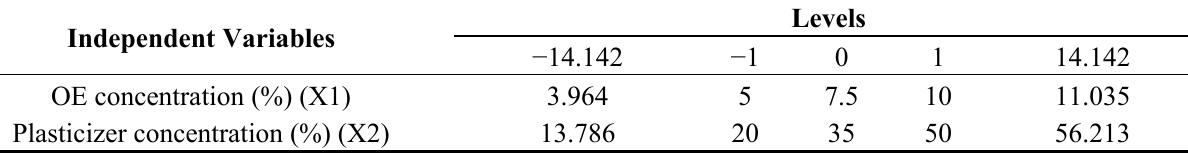
Table 1. Independent variables and levels used for surface response composite central